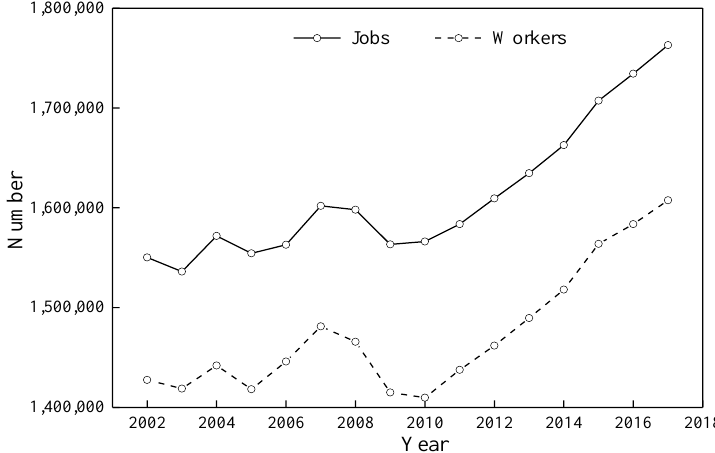
Figure 3. Trend in total number of jobs and workers in the Twin Cities.